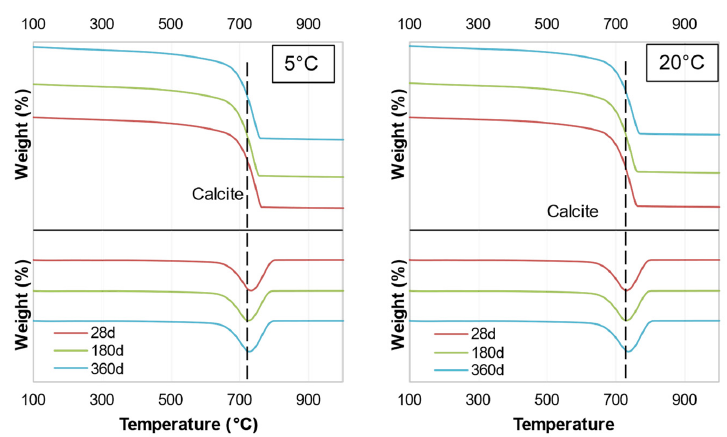
Figure A6. TGA results of S + F + W3.